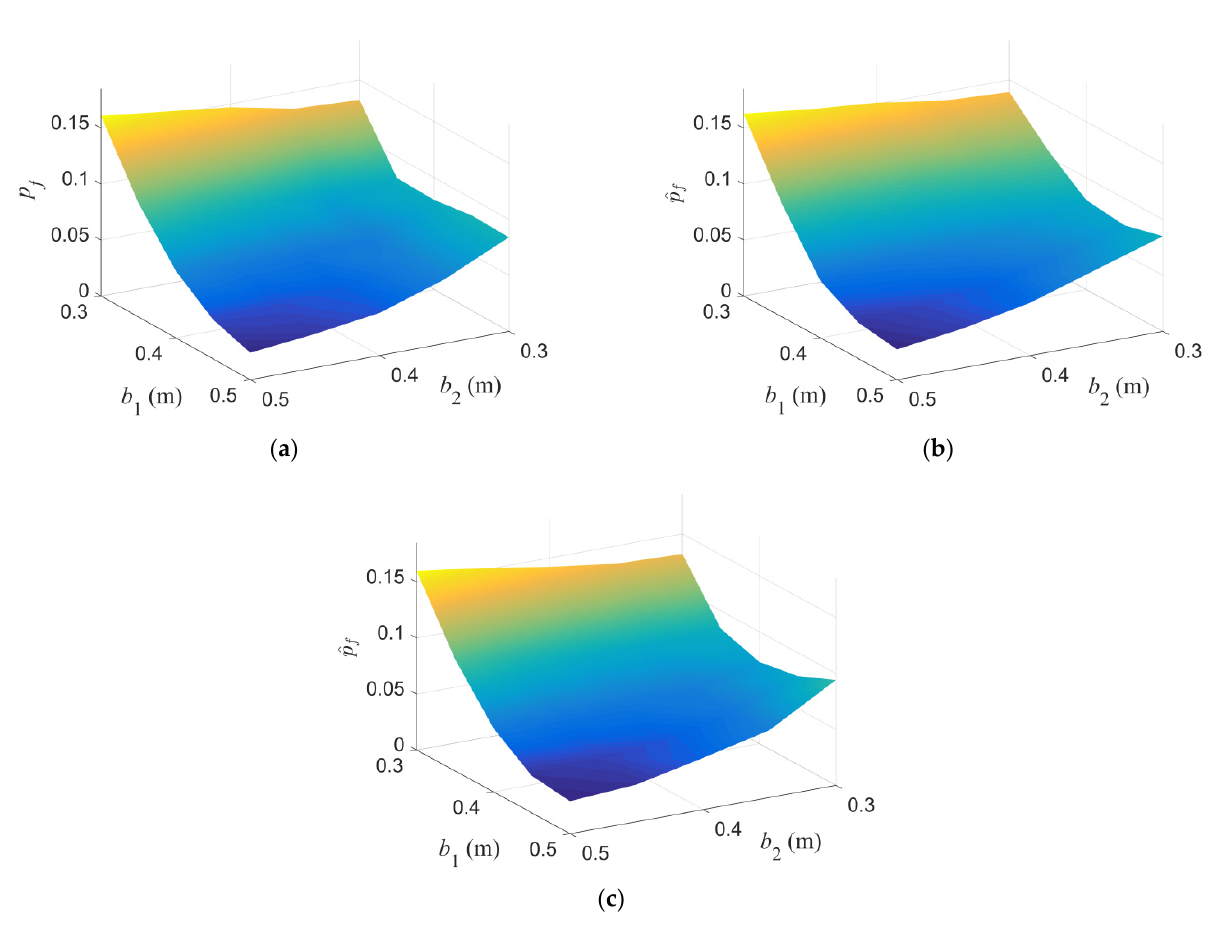
Figure 11. Surface of failure probability in Example 2. ( a ) MCS. ( b ) EGO-EGRA. ( c ) Proposed method.